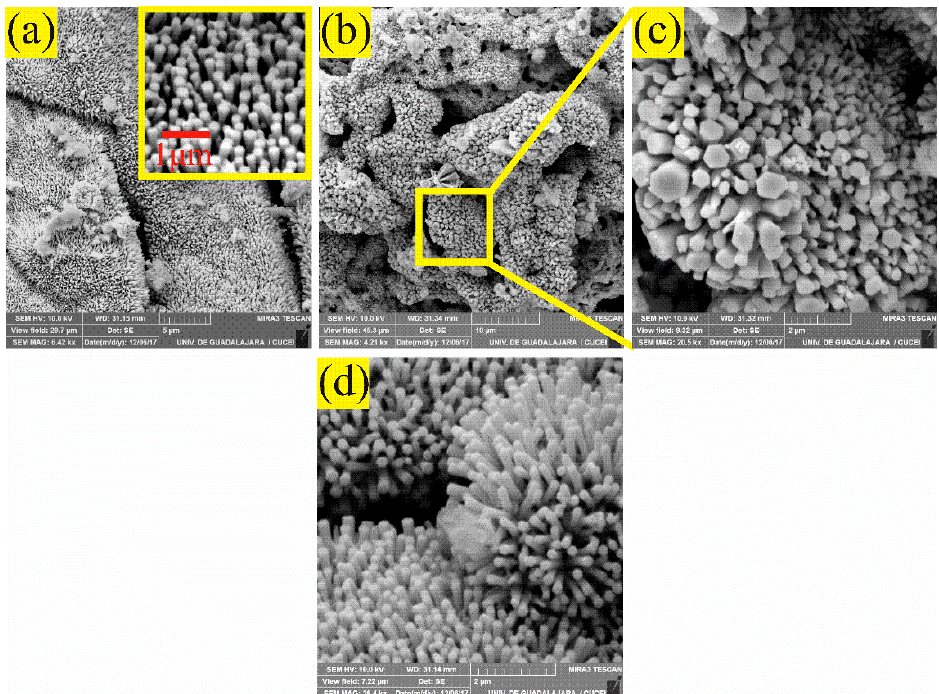
Figure 5. SEM images showing the formation of microrods at 300 °C, at magnifications: ( a ) 6.42 kX, ( b ) 4.21 kX, ( c ) 20.5 kX, and ( d ) 26.4 kX.